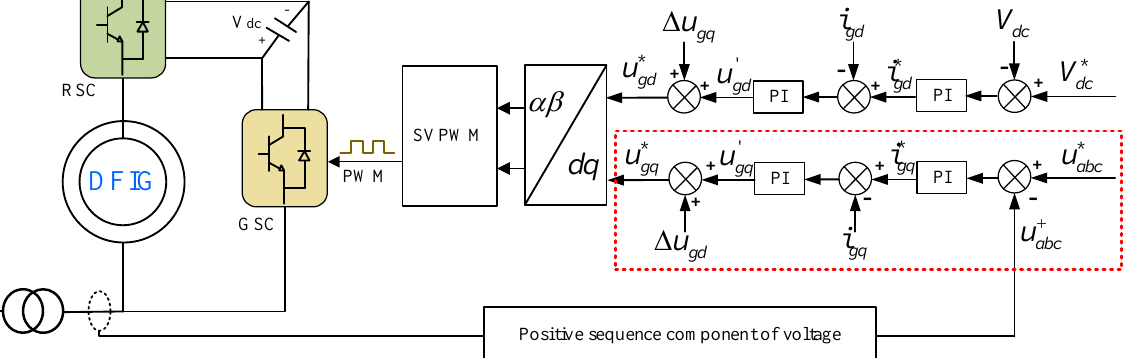
Figure 5. Structure diagram of grid-side converter.